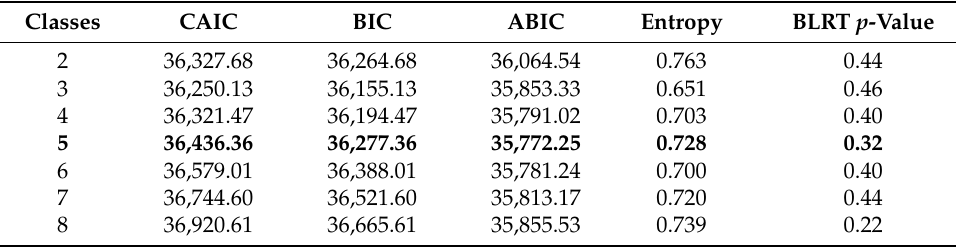
Table 1. Goodness of Fit Values for Models with 2–8